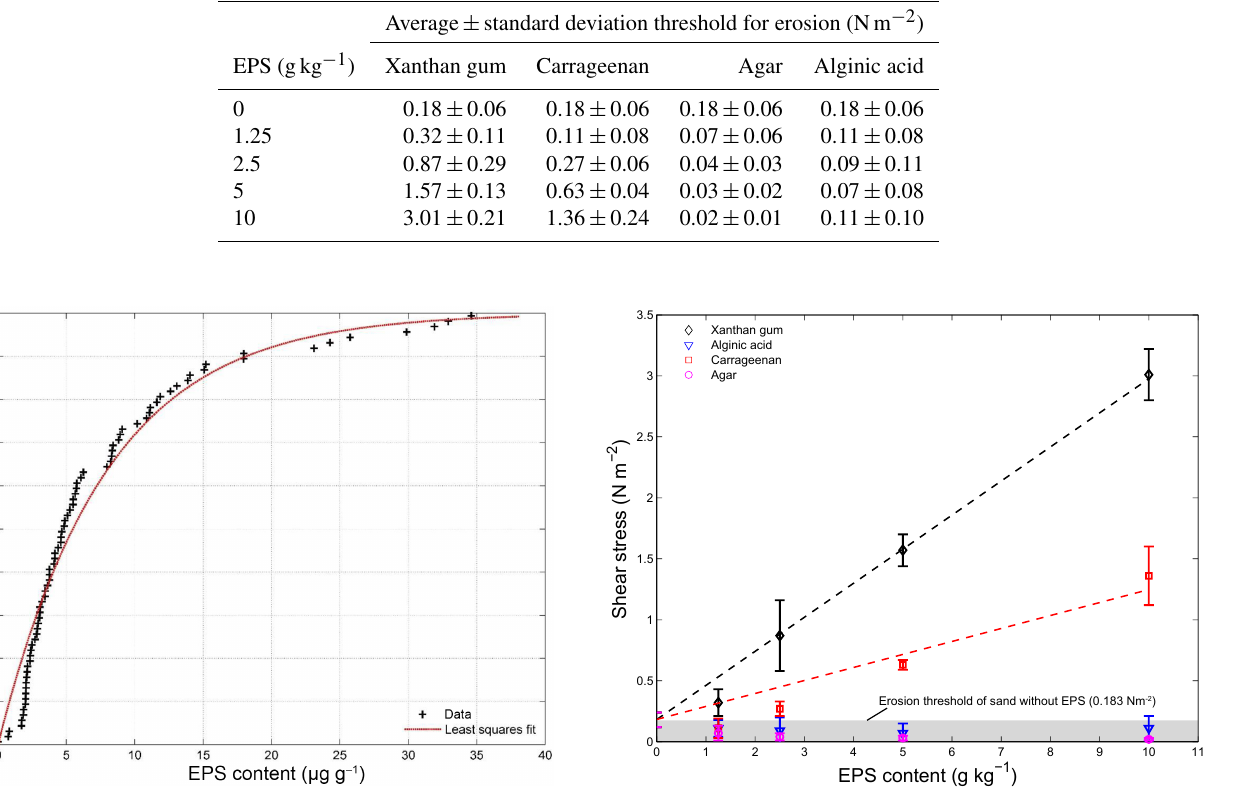
Figure 3. EPS content measurements made during natural biofilm growth experiment. The measurements ( n = 80) are best described by a least squares exponential fit with a mean parameter µ of 7.88.